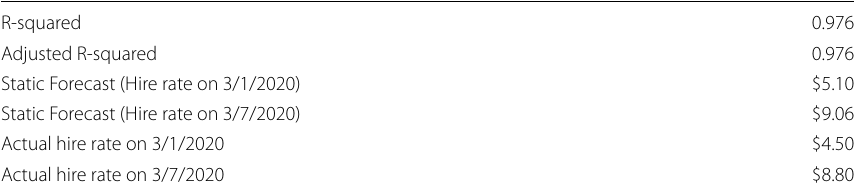
Table 7 Transpacific R/V 72.000 dwt. Source : Elaboration by the authors